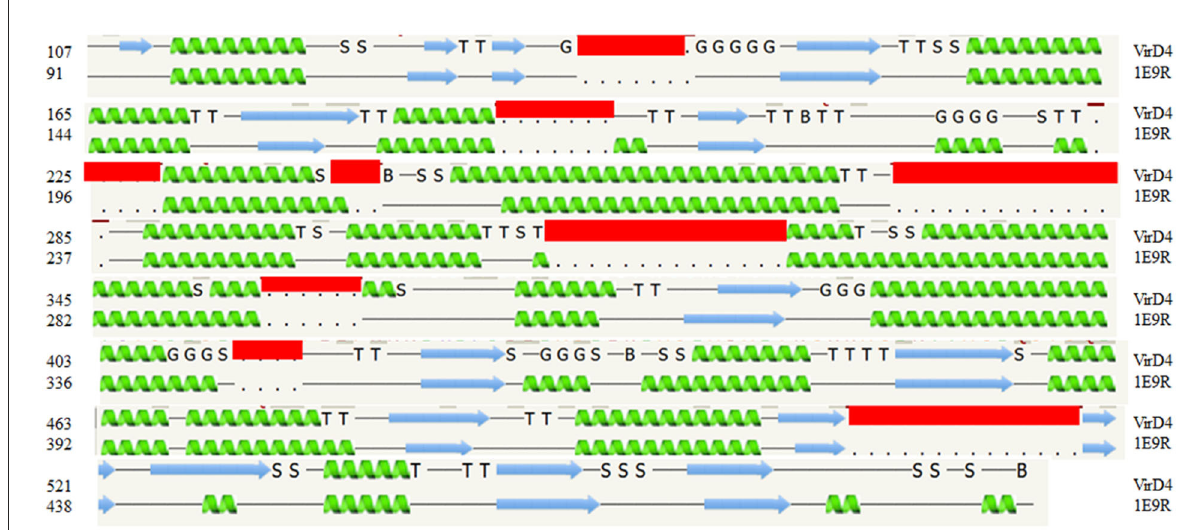
FIGURE1 The secondary structure alignment between the template structure (1E9R) and Salmonella enterica VirD4 sequence. The secondary structure prediction shows that approximately 400 amino acids are aligned very well between them. The S. enterica VirD4 protein sequence has several insertion regions, which are shown in the red box. The α -helix prediction is shown in green, and the β -strand is shown by the blue arrow. In this figure, G-indicates the 3-turn helix, T-indicates the hydrogen-bonded turn, and S indicates the bend. The top row is VirD4 starts with residue 107, and the bottom row is template starts with residue